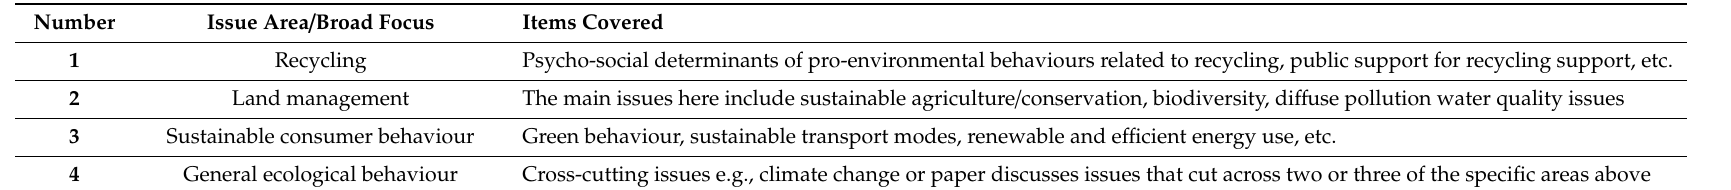
Table 2. Classification of Papers based on Di ff erent Environmental Policy